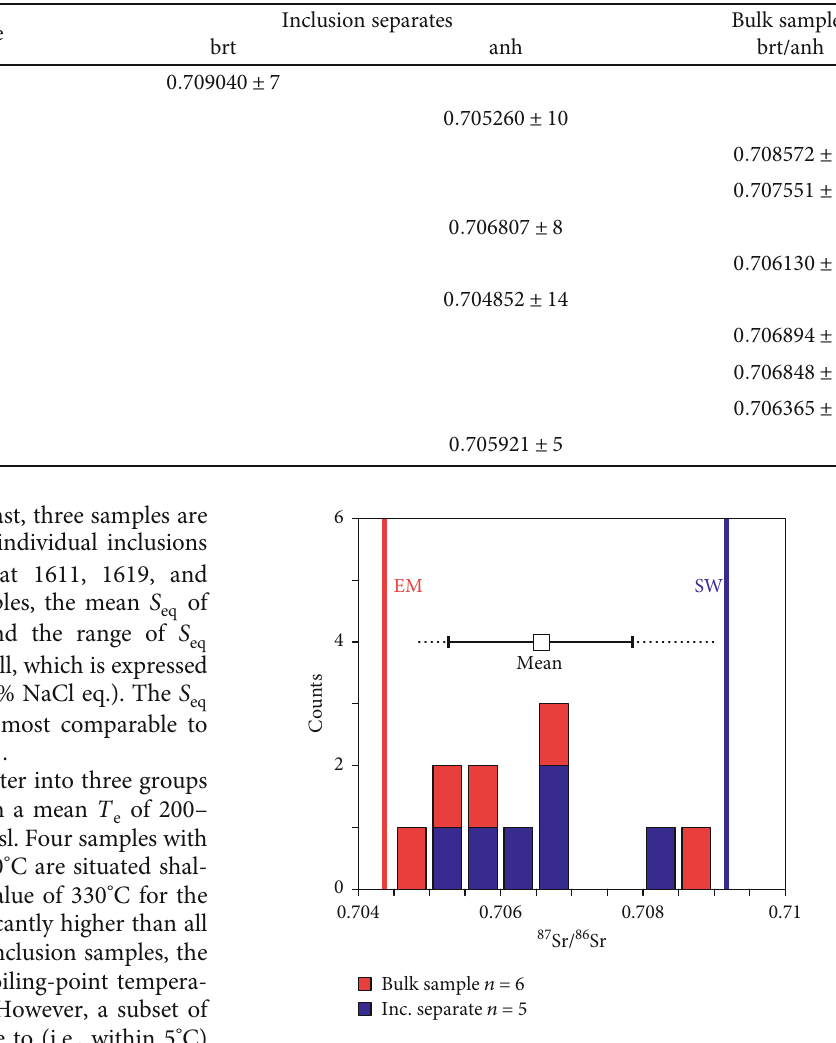
Figure 8: Histogram of 87 Sr/ 86 Sr values of mineral separates and adjacent bulk samples from stockwork and chimney samples. The red and blue vertical lines show the 87 Sr/ 86 Sr of hydrothermal end- member (EM) and seawater (SW) after Diehl [47]. The horizontal lines show the mean value ± SD (thick black line) and the minimum to maximum value (dotted line) measured in 11 samples.